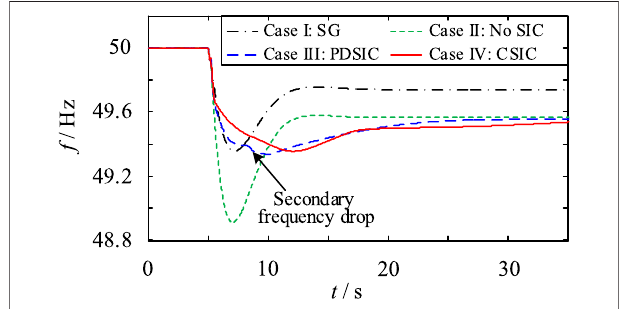
FIGURE 9 | System frequency response characteristics in four cases.